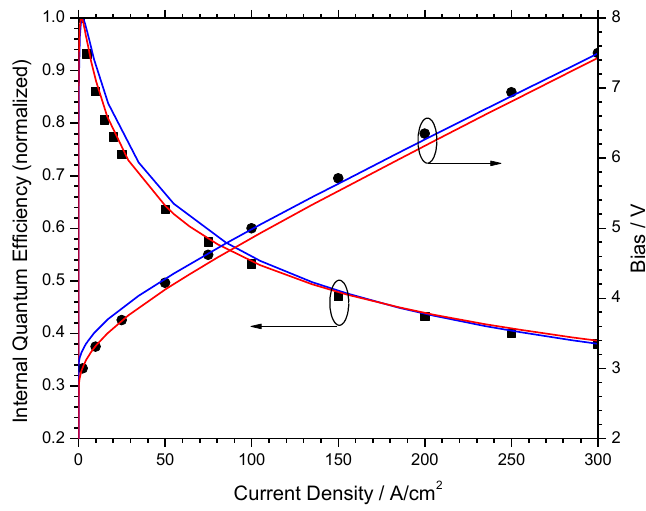
Figure 12. Normalized IQE and bias vs. current density (symbols—measurement; red lines—simulation favoring Auger recombination; blue lines—simulation favoring electron leakage) [29].